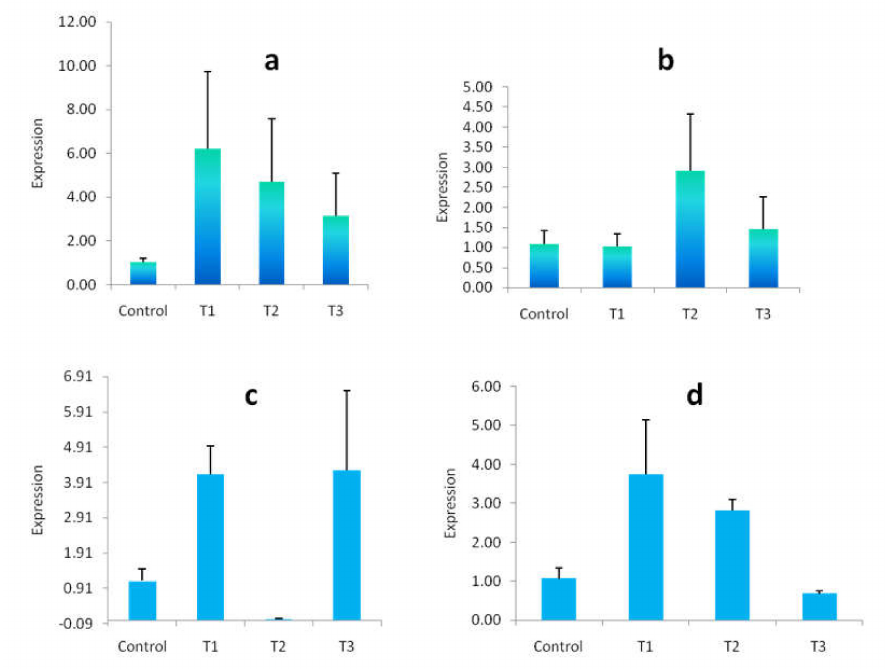
Figure 9. Effect of arsenic on relative mRNA expression of heavy-metal-induced genes ( MT and HSP60 ). ( a ): Expression of MT gene in muscle tissue. ( b ): Expression of MT gene in gill tissue. ( c ): Expression of HSP 60 gene in muscle tissue. ( d ): Expression of HSP 60 gene in gill tissue. Expression values are presented as Mean ± SE (presented as bar diagram). Control: 0.0 mg/L, T1: 2.5 mg/L, T2: 15 mg/L and T3: 30